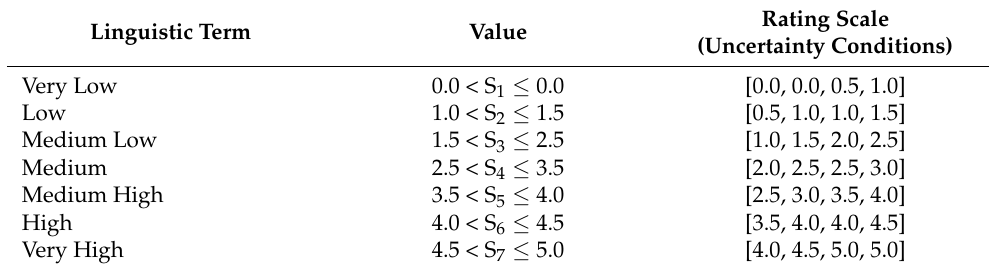
Table 5. Sample Course rating scale.